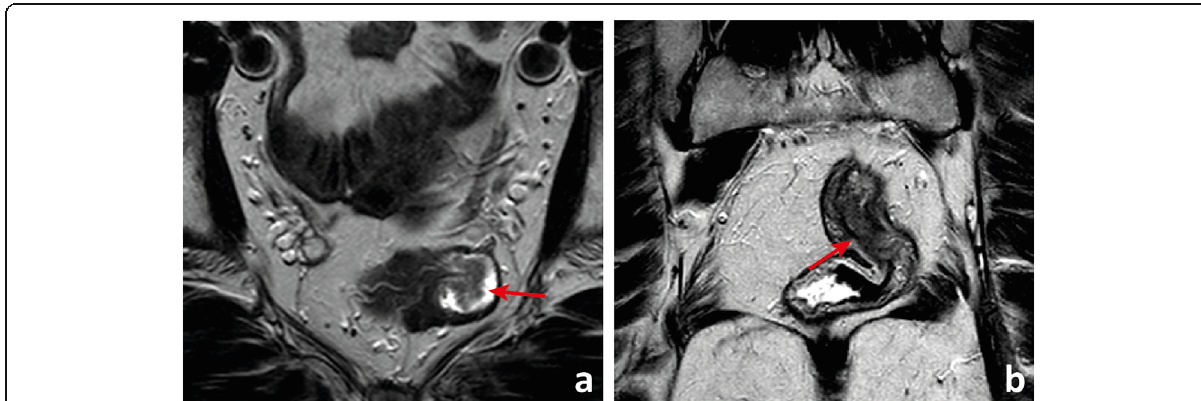
Fig. 18 Two different patients with two different early rectal cancers are depicted in a and b . In a , a thin submucosal fat plane is observed between the intermediate signal intensity tumour and the tented muscularis propria . Tumour may therefore be staged as mrT1sm1/2. Pathology of the total mesorectal excision specimen revealed a pT1sm1; in b , the tumour abuts the inner circular layer of the muscularis propria and may therefore be staged as mrT1sm3/earlyT2. Pathology of the total mesorectal excision specimen revealed a pT1sm3